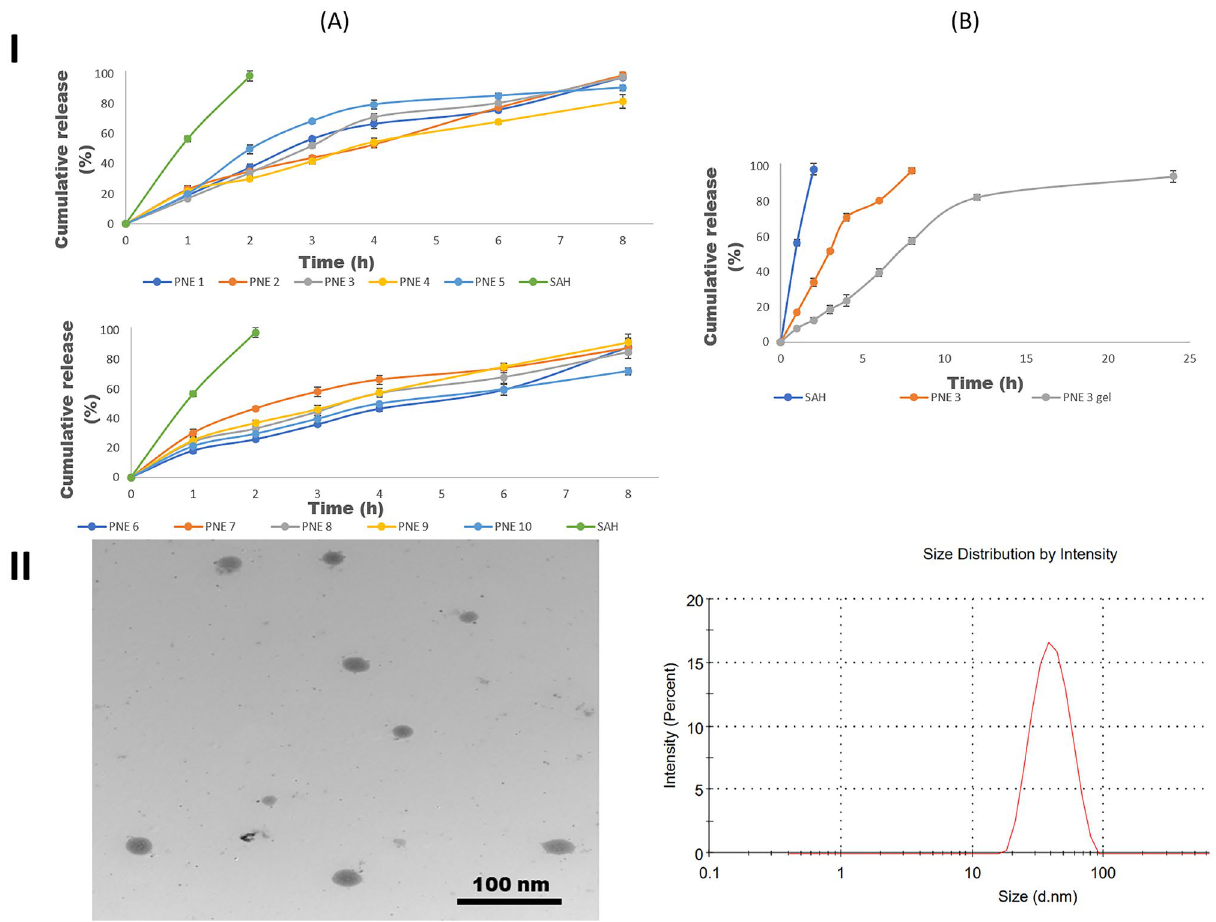
Figure 3. ( I ) ( A ) Release profiles of SAH and PNEs, and ( B ) Release profiles of SAH, the optimized PNE (PNE 3), and PNE 3 gel, in phosphate buffer (pH = 6, simulating skin surface pH) at 32 ± 0.5 micrograph of the optimized PNE 3 (Left) and its size distribution graph